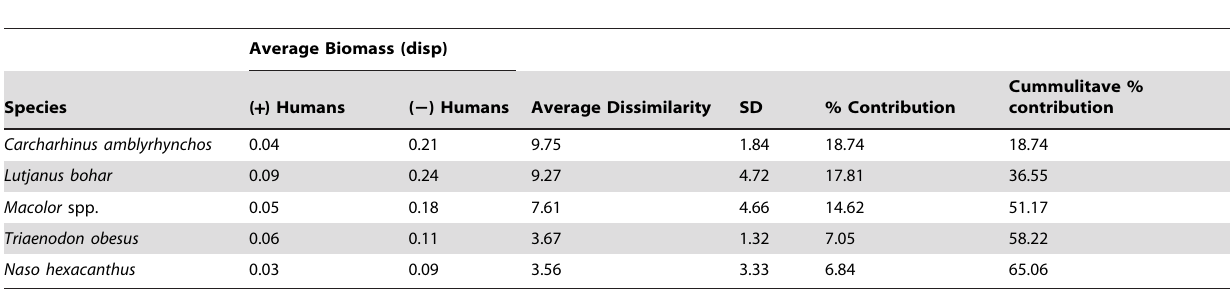
Table 4. SIMPER analysis results showing species contribution to the dissimilarity between significant SIMPROF groupings based on species-level biomass (dispersion-weighted) and human